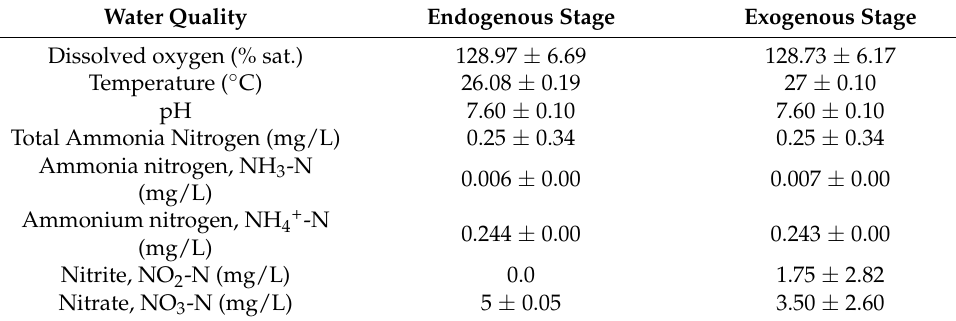
Table 2. The water quality profile in the water treatment